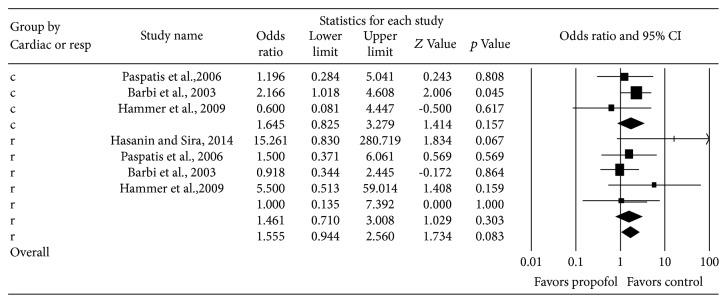
Subgroup analysis.